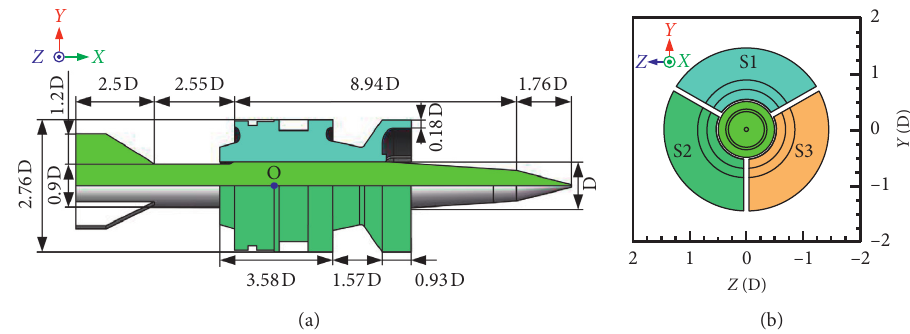
Figure 6: Model definition. (a) Model configuration and dimension (D) and D � 10.8mm. (b) Sabot number.